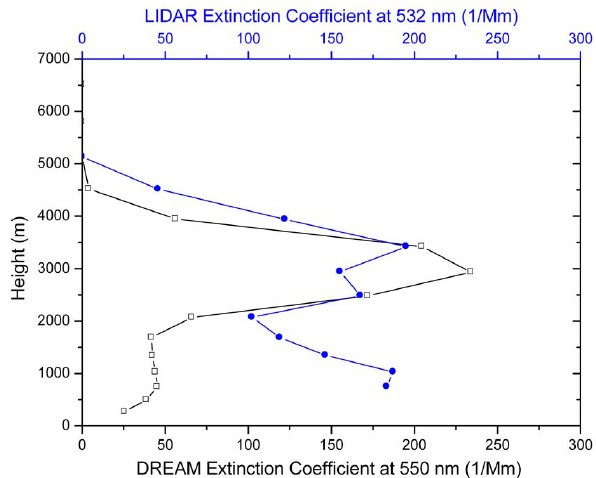
Fig. 7. Comparison of extinction coefficient profile simulated by BSC-DREAM at 550nm (only for dust) and observed by Raman lidar measurements at 532nm over Athens, on 20 May 2008 at 18:00UTC. Raman lidar signals were averaged between 17:25 and